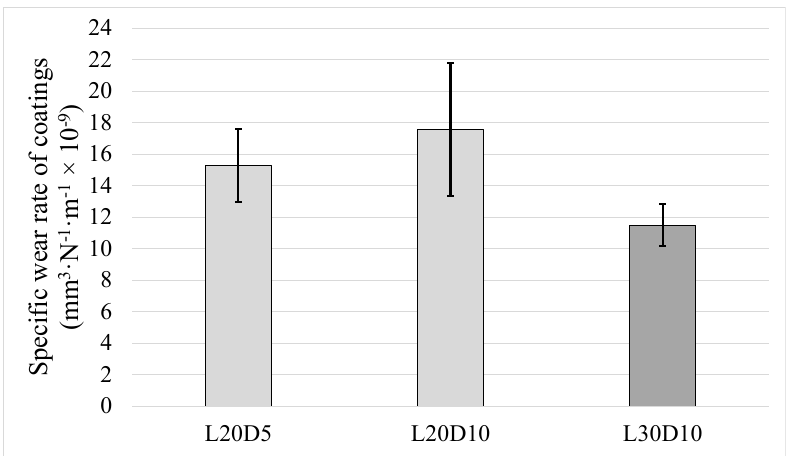
( b ) Figure 9. SEM images of wear tracks at different normal loads of 30 N and 40 N. ( a ) L30D5 and ( b ) L40D5 3.4. Influence of Sliding Distance on Wear Rate Running the test for longer time (longer sliding distance) is another way to investi- gate any changes in wear rate. Three tests were conducted for this matter: two with the same load of 20 N and different sliding distance of 5 km and 10 km (L20D5 and L20D10) and one with normal load of 30 N and distance of 10 km (L30D10). Figure 10 shows spe-